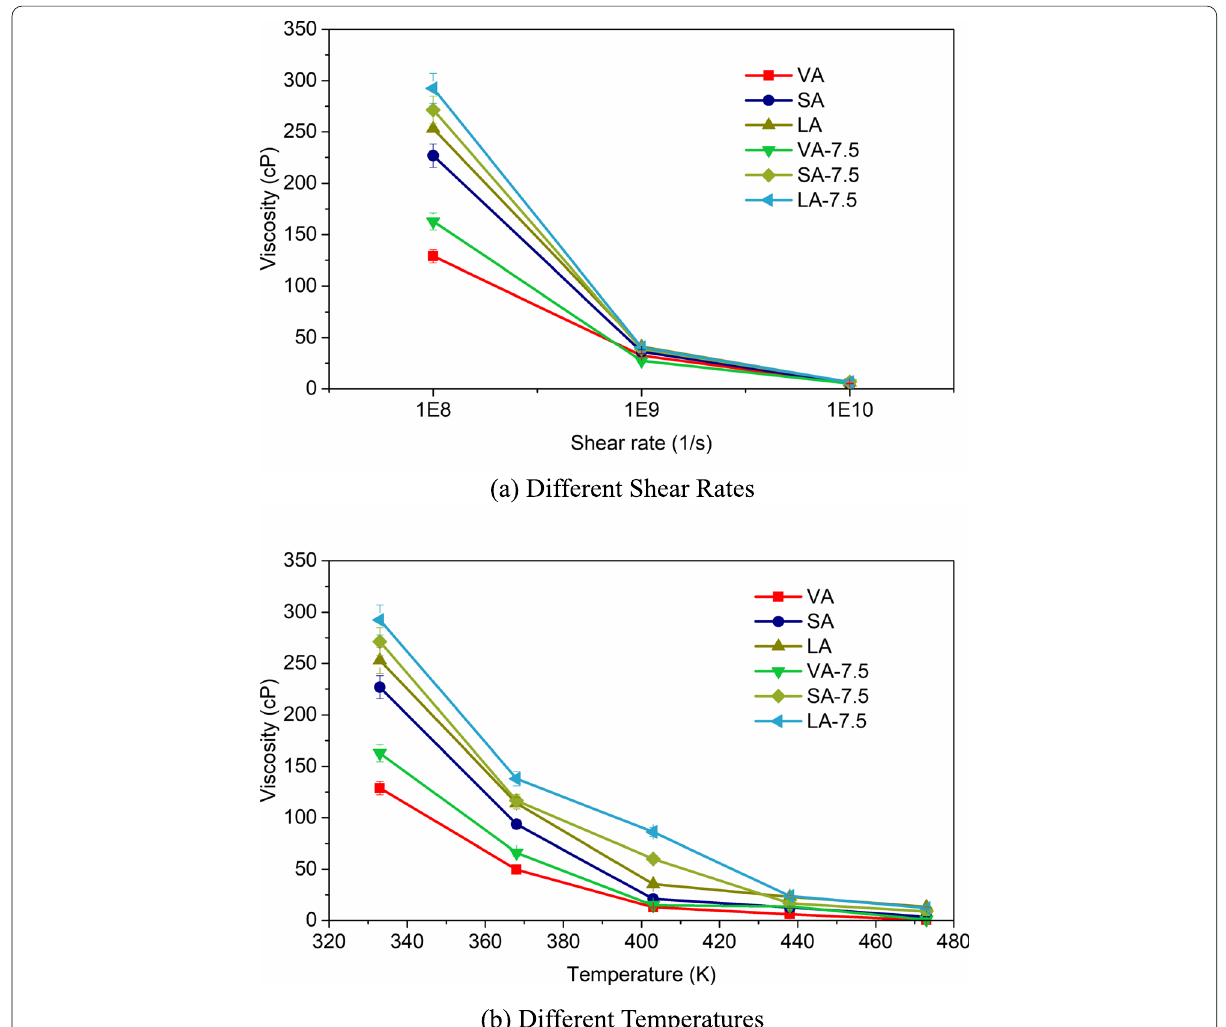
Fig. 9 Viscosity of Asphalt Models at Different Aging Levels during 60 ns All-Atom MD Simulations: ( a ) Different Shear Rates, and ( b ) Different is shown in Fig. 12. The relationship between intra- molecular energy and temperature is almost a straight line. Conversely, a glass transition region appears in the intermolecular energy (van der Waals energy and elec- trostatic energy) versus temperature curve. This means that from an energy perspective, with the change of temperature, the generation of glass transition behavior is mainly related to the intermolecular energy. According to the above analysis, the MD simula- tions results are similar to previous study results based on the real asphalt in the laboratories. Therefore, it is reasonable that the simulation method and the asphalt molecule model can predict the properties of asphalt accurately.